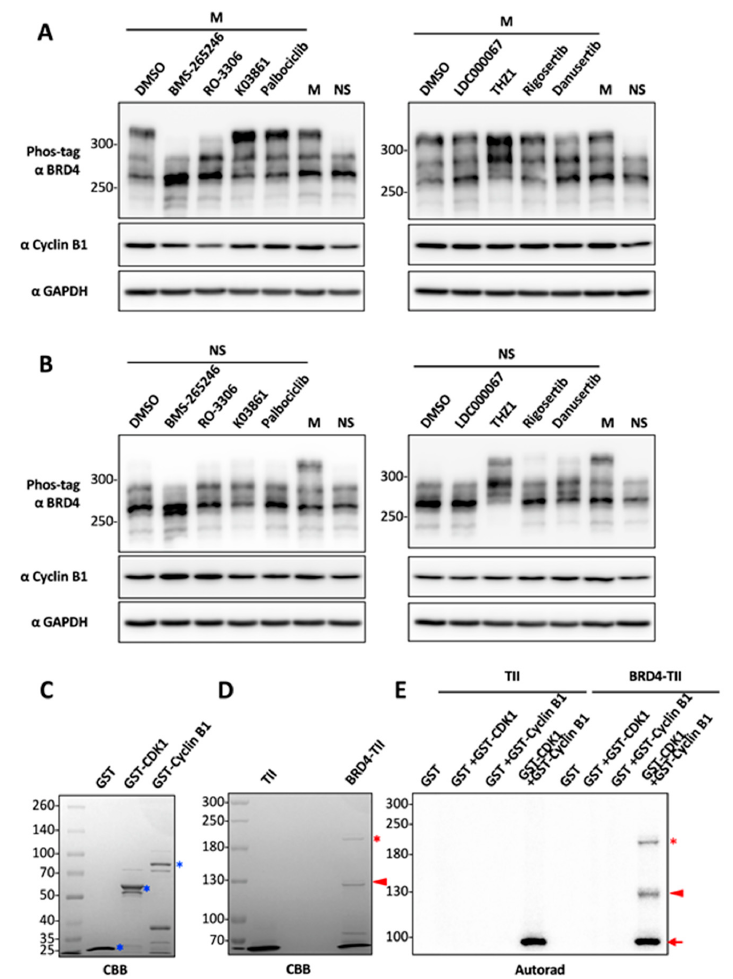
Figure 2. CDK1 is a potential kinase that mediates BRD4 mitotic hyperphosphorylation. ( A ) HEK293T cells were synchronized in mitosis (M) using nocodazole and treated with DMSO or 1 µ M of the indicated kinase inhibitors for 1 h. Whole-cell lysates were resolved in Phos-tag gel and immunoblotted with indicated antibody. The untreated mitotic (M) and not-synchronized (NS) cell lysates were loaded on the right as controls. ( B ) HEK293T cells (not synchronized, NS) were treated and analyzed as in ( A ). ( C ) GST, GST-CDK1 and GST-Cyclin B1 proteins purified from E. coli were analyzed by SDS-PAGE and Coomassie Brilliant Blue (CBB) staining. Asterisks mark the purified GST or GST fusions. ( D ) TII control and BRD4-TII expressed in E. coli were affinity purified using IgG beads, resolved in 5.5% SDS/PAGE and visualized using CBB staining. TII, which has a molecular weight of approximately 16 kDa, has run off the gel. This lane serves as a negative control to identify the BRD4-specific bands in the BRD4-TII lane. Asterisks mark the full length BRD4-TII. Triangles mark a shorter fragment of BRD4-TII. ( E ) Recombinant TII control and BRD4-TII purified with IgG beads were subjected to in vitro kinase assay using purified GST, GST-CDK1, and / or GST-Cyclin B1 as indicated. The samples were analyzed by SDS-PAGE and autoradiography. Asterisks mark the full length BRD4-TII. Triangles mark a shorter fragment of BRD4-TII. The arrow marks phosphorylated GST-Cyclin